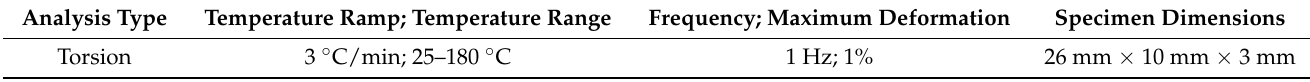
Table 6. Dynamic mechanical analysis (DMA)